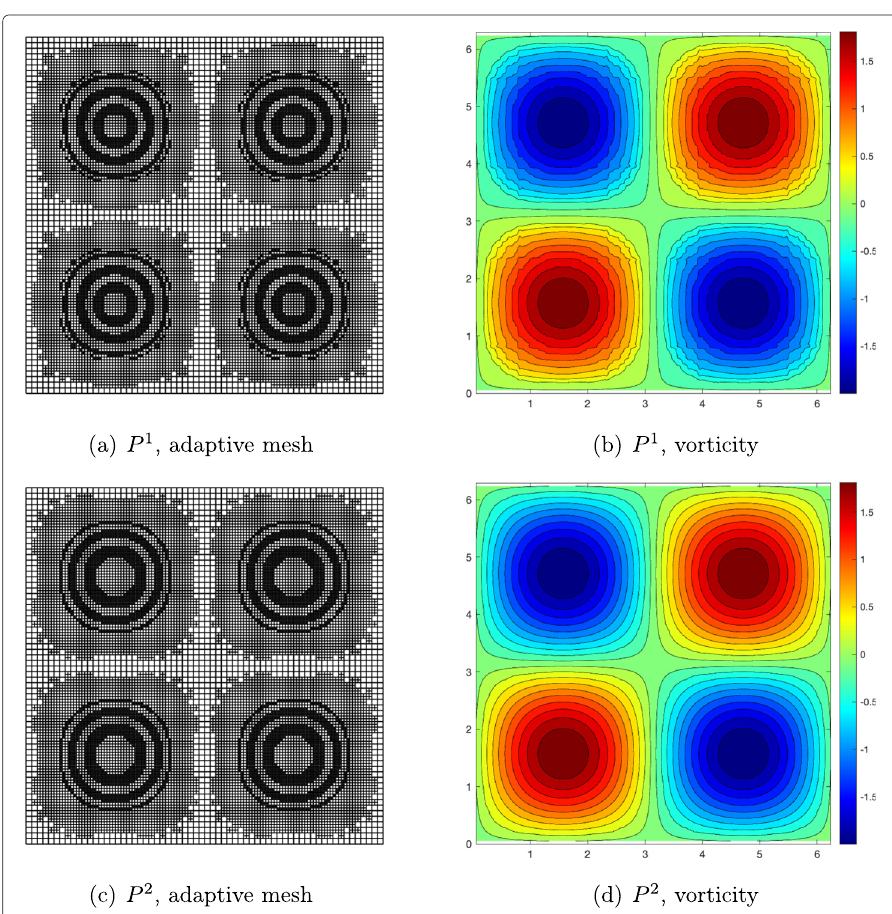
Fig. 8 Taylor-Green vortex. Adaptive mesh and vorticity contours with 20 equally spaced contour lines from -1.998 to 1.998